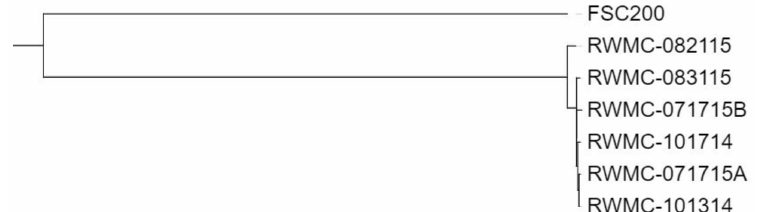
Figure 2. Phylogenetic analysis of the WGS and core genome SNPs obtained for the six wild-type F . tularensis type B strains isolated from the blood of infected individuals from the same region in the United States with tularemia, along with prototype strain FSC200 for comparison. The rooted dendrogram was generated with the CSI Phylogeny tool and the resulting SNP-based tree was obtained for both analyses. A correlation coe ffi cient of 0.99 was obtained for this